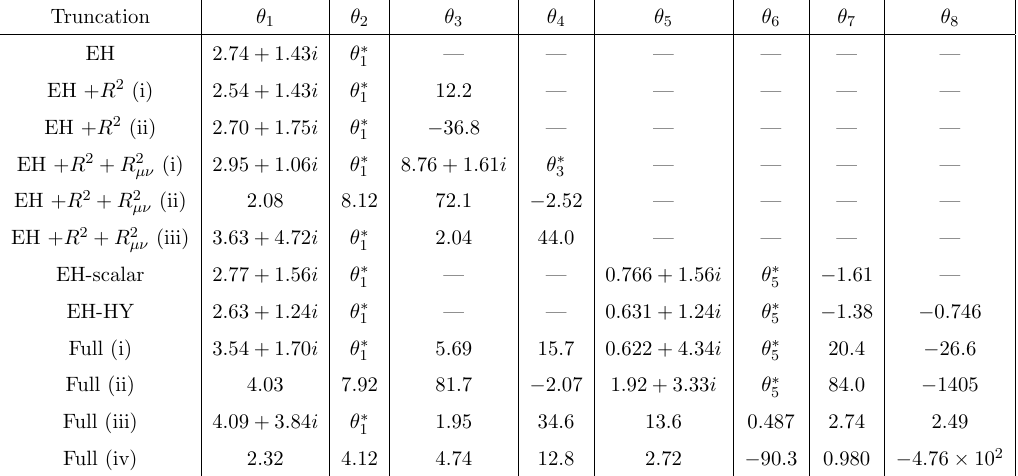
Table 2 . The values of critical exponents for (cid:11) = 0 and (cid:12) = 1. \EH", \HY" and \Full" denote the Einstein-Hilbert truncation, the Higgs-Yukawa term and the theory space (2.1), respectively.